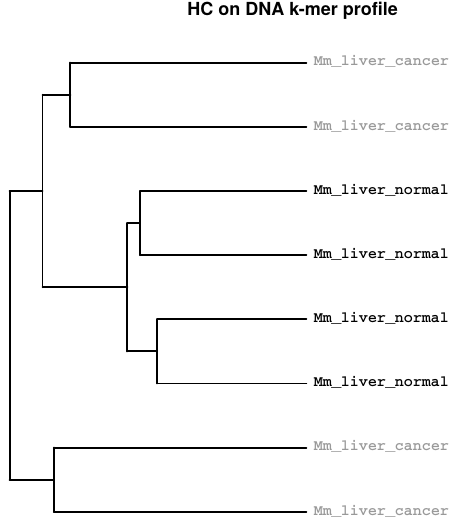
Figure 1. Clustering according to experimental groups. B16-F10 melanoma cells were injected into portal veins in mice resulting in intrahepatic tumor growth. After 14 days, endothelial cells from hepatic tumors and from livers of healthy mice were extracted and analysed with RNAseq (single end). Differential gene expression had been focused on 1255 metabolic genes expressed in endothelial cells. The sample data was downloaded from ArrayExpress (accession